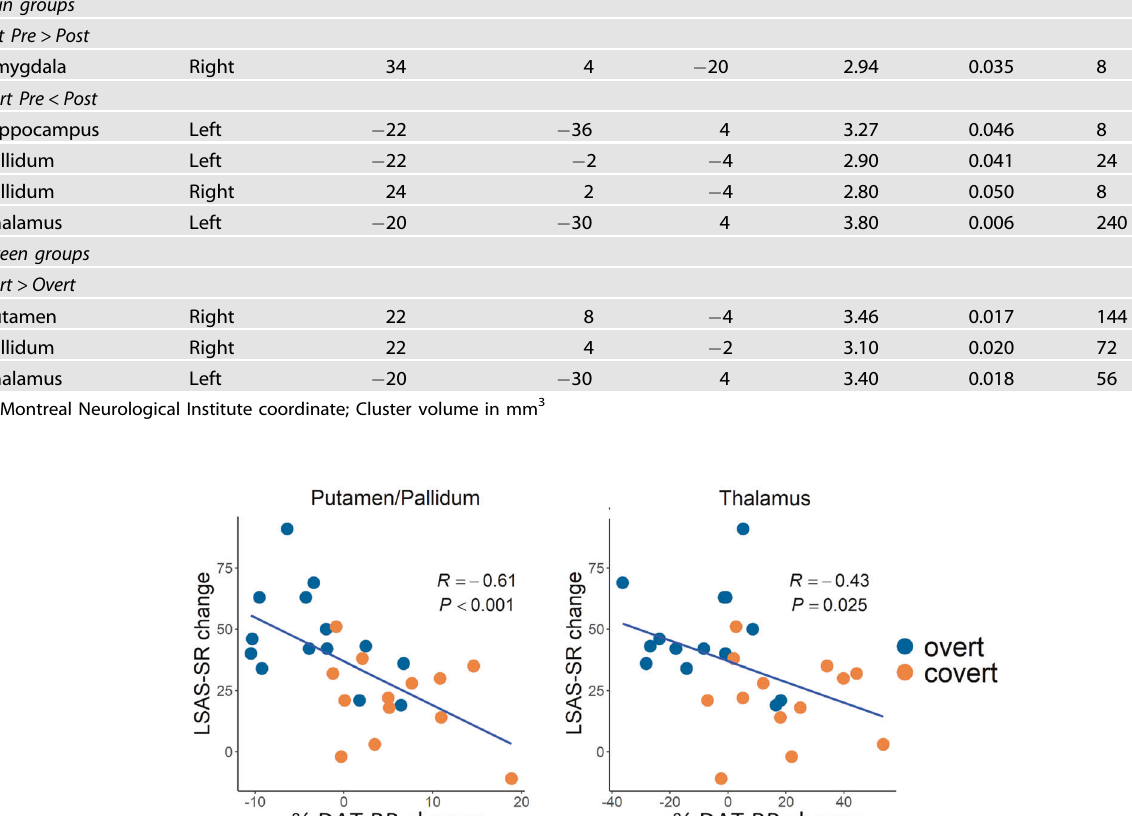
Table 1. Brain regions showing differences in dopamine transporter binding potential change after overt and covert SSRI treatment.